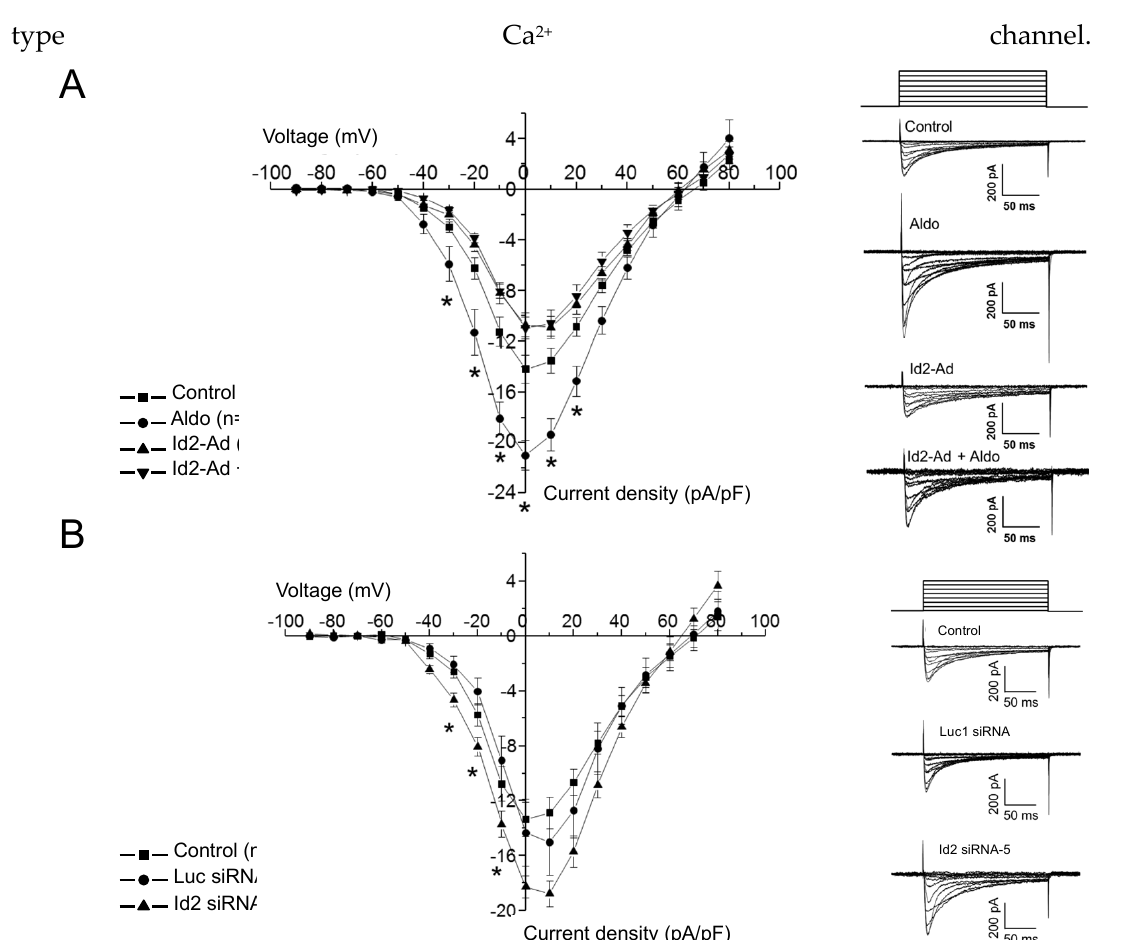
Figure 4. Manipulation of Id2 (cid:48) s expression altered of voltage-gated Ca 2+ currents in neonatal rat ventricular cardiomyocytes. Voltage-gated Ca 2+ currents were measured by whole-cell patch-clamp experiments under the voltage-clamp mode. Graphs show the mean current-voltage relationship. currents measured in ventricular neonatal rat cardiomyocytes. ( A ) Graphs show the mean current-voltage relationship (IV curve) of voltage-gated Ca 2+ currents measured in ventricular neonatal rat cardiomyocytes. Ca 2+ currents were measured from a holding potential of − 90 mV and depolarized by 10 mV voltage steps to +80 mV, as described in Methods. (A) IV curves recorded from cells that were treated (Aldo, • (cid:3) ) or non-treated (Control, (cid:4) ) with 1 µ mol/L aldosterone for 24 h and in the same cells overexpressing Id2, treated (Id2-Ad + Aldo, (cid:78) ) or non-treated (Id2-Ad, (cid:72) ) with aldosterone (Aldo) at 1 µ mol/L. Right traces are representative recordings traces for cells non-treated (Control), treated (Aldo) with aldosterone at 1 µ mol/L (Aldo) (n=10 to 11 cells). ( B ) IV curves of Ca 2+ currents recorded in non-treated cardiomyocytes ( (cid:4) ) and cardiomyocytes transfected with Id2 siRNA (siRNA Id2-5, (cid:78) ) or control siRNA (siRNA Luc1, • (cid:3) ) ( n = 7–12 cells). Data are the mean ± s.e.m of 7 to 12 individual cardiomyocytes, as indicated in the figure for each condition from 3 to 4 different cell isolations. * p < 0.05, from unpaired student’s t - test .